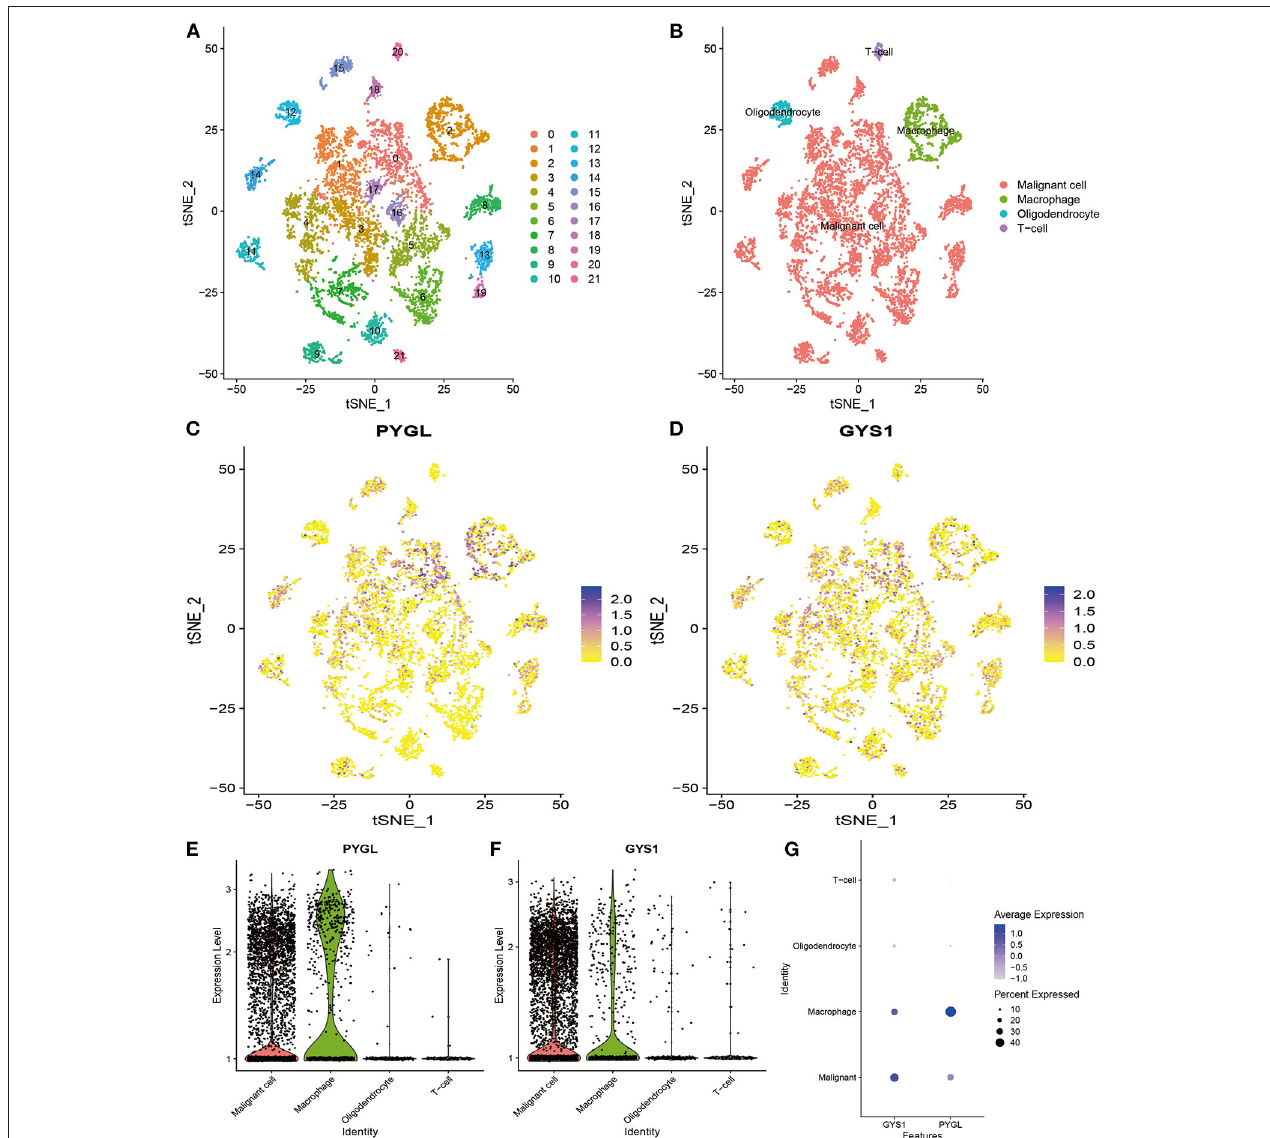
FIGURE 6 | Analysis of Single-cell mRNA sequencing. (A) Two-dimensional TSNE plot depicted that 7,930 single cells were classified into 22 clusters and shown with distinct colors. (B) Twenty-two clusters were divided into 4 types of cells: malignant cell, macrophage, oligodendrocyte and T-cell. (C) The expression of PYGL in each cell. (D) The expression of GYS1 in each cell. (E) The violin plot showed the expression of PYGL in each type of cell. (F) The violin plot showed the expression of GYS1 in each type of cell. (G) The bubble plot showed the expression of PYGL and GYS1 in each type of cell.